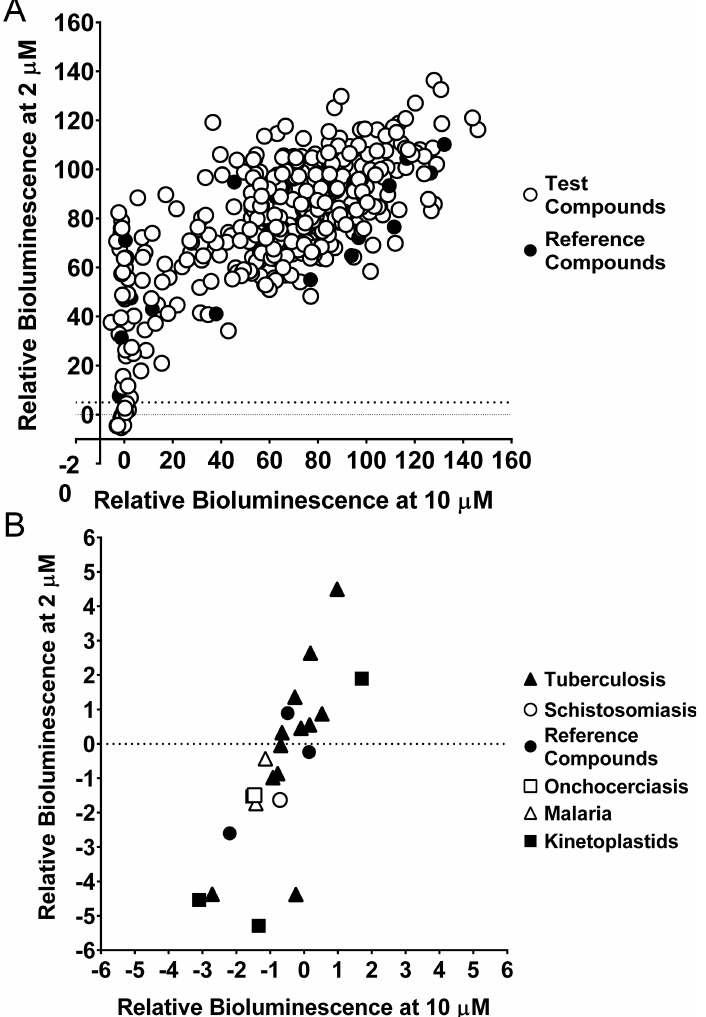
Fig 3. Screening the MMV Pathogen Box against NanoLuc-PEST expressing axenic amastigotes, using bioluminescence. (A) Relative bioluminescence (compared to untreated controls) of L . mexicana expressing NanoLuc-PEST was measured following treatment with compounds at two concentrations (2 and 10 μ M). Reference compounds in the MMV Pathogen Box (see S2 Table) are shown as filled circles. Mean values are shown (n = 4). The dotted line indicates the level of relative bioluminescence (5% or less at 2 μ M) that forms our cut off for compounds to be considered hits. (B) Represents the bottom left of Fig 3A, and shows the 23 compounds identified as hits from our screen of the MMV Pathogen Box. These compounds are depicted as the MMV Pathogen Box disease set: tuberculosis (filled triangle), schistosomiasis (open circle), onchocerciasis (open square), malaria (open triangle), kinetoplastids (filled square) and reference compounds (filled circle). The reference compounds shown here are Buparvaquone, Mebendazole and Auranofin. Mean values are shown (n = 4) from two independent experiments.